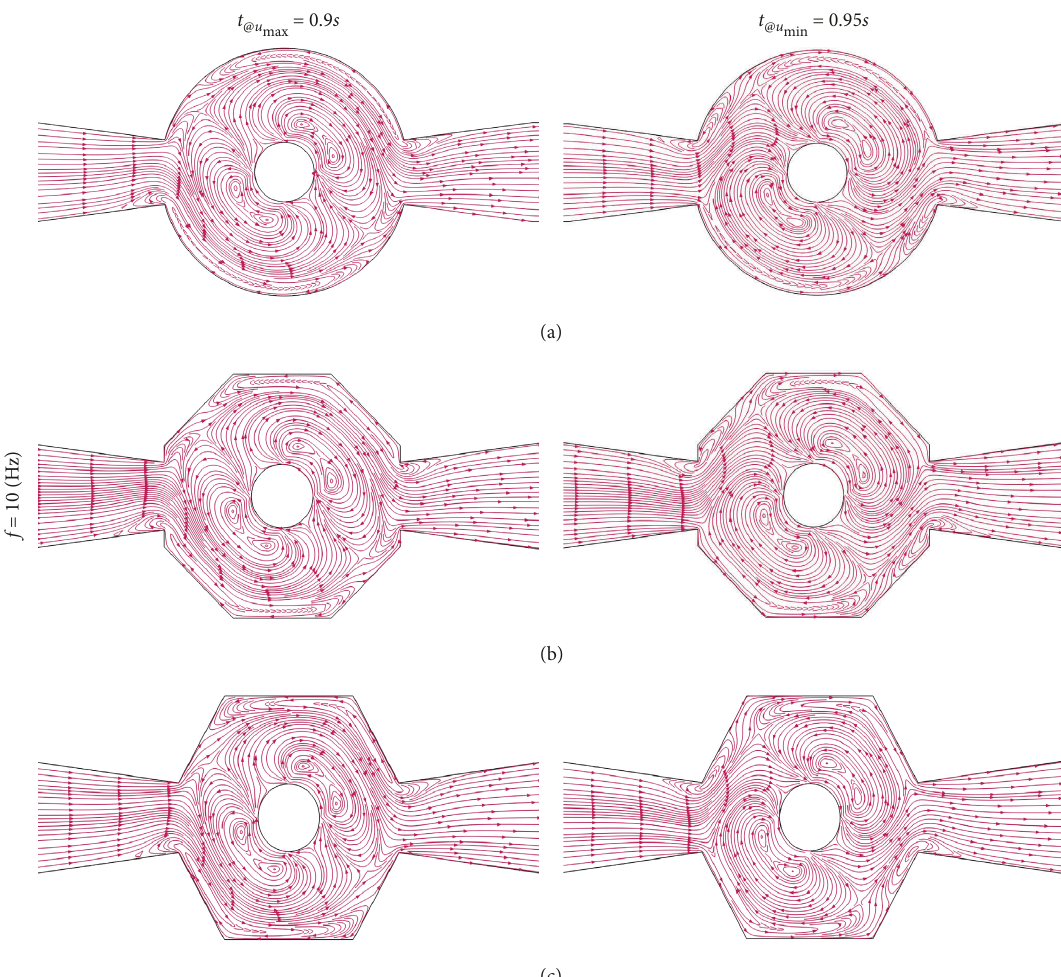
Figure 12: Streamlines in (a) circular, (b) octagonal, and (c) hexagonal mixing chambers for the maximum (left) and minimum (right) velocities in the final cycle at f � 10Hz ( u � 0.1mm · s − 1 , φ � π